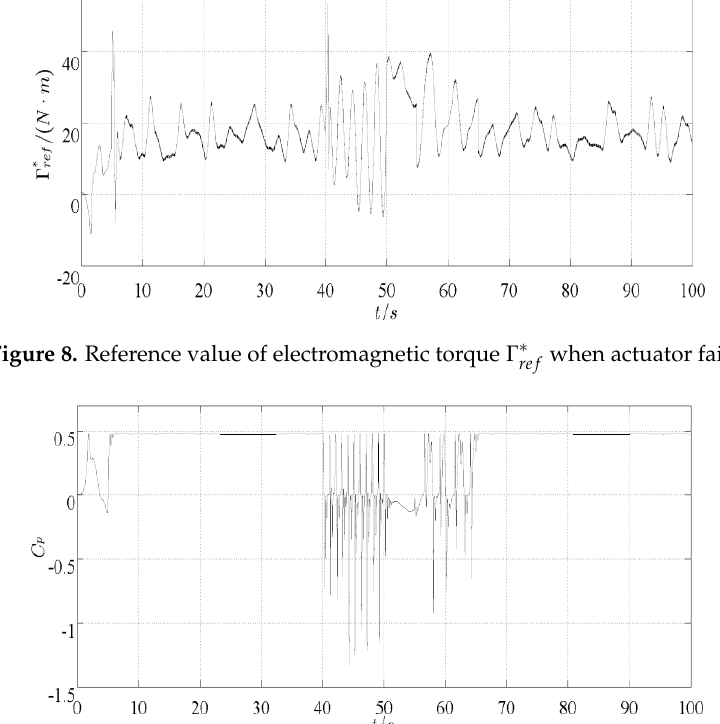
∗ after fault-tolerant control